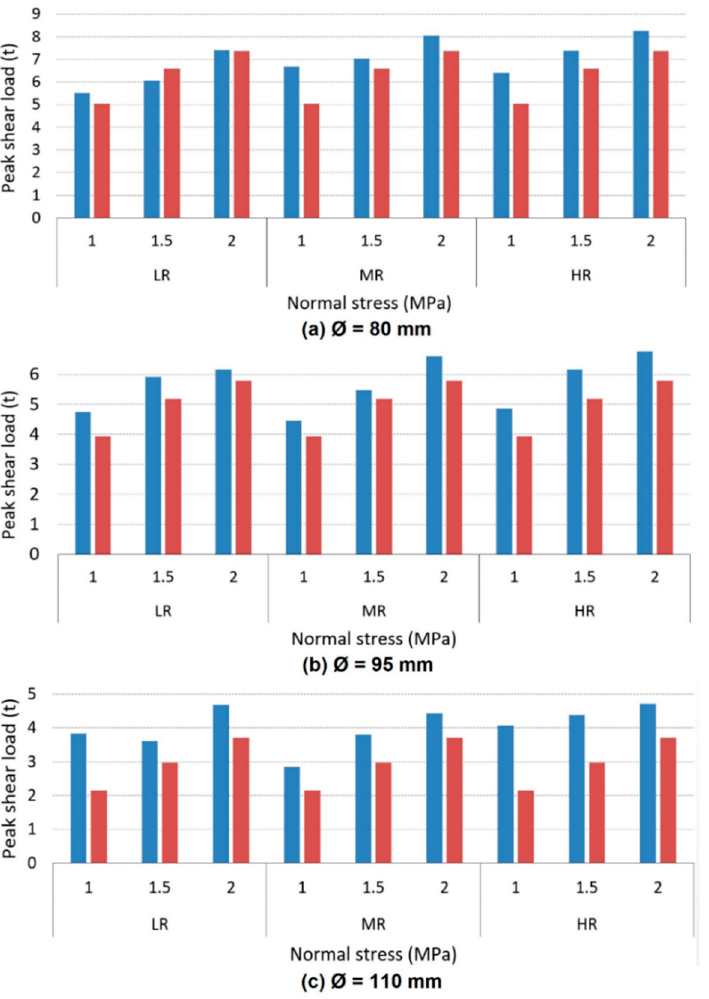
Figure 11. Comparison of the shear strength of the specimens containing a non-persistent rough joint obtained from case II experiments (blue bars) with the ones from case I experiments (red bars) when the joint diameter is ( a ) 80, ( b ) 95, and ( c ) 110 mm.